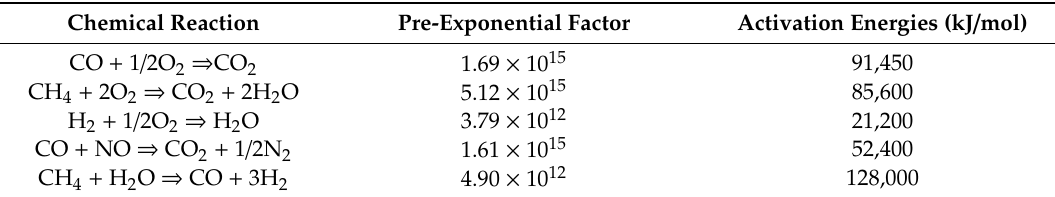
Table 6. Catalytic reaction mechanism used in simulation.